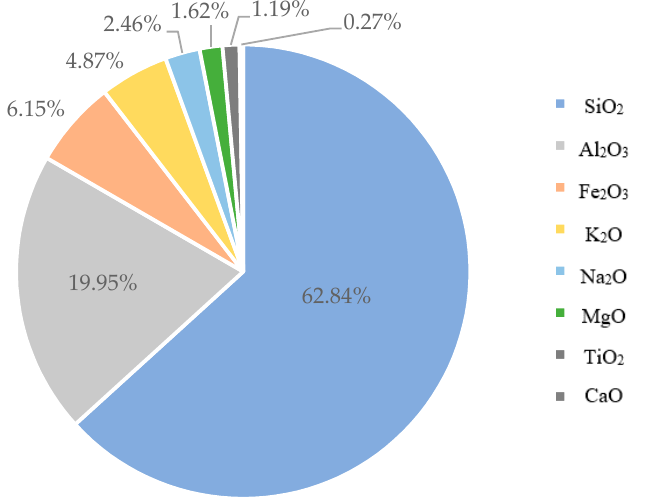
Figure 4. Particle size distribution (PSD) curve of brick soil used in this study.